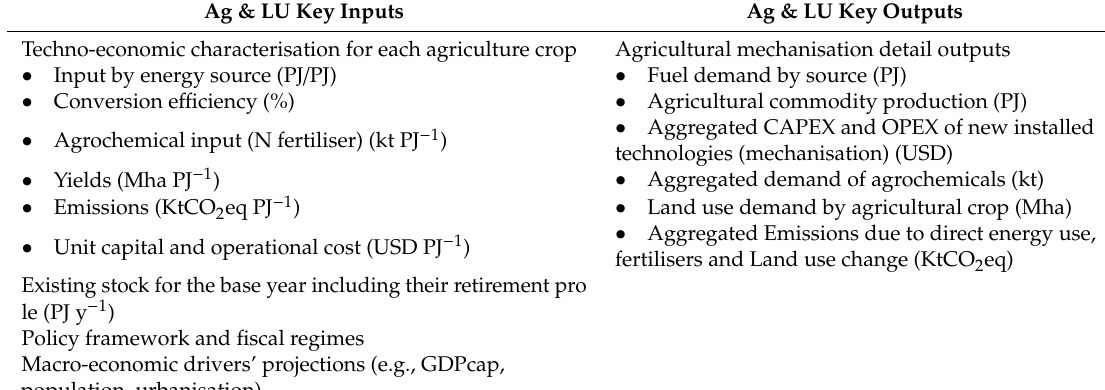
Table 9. Main inputs and outputs from the model.